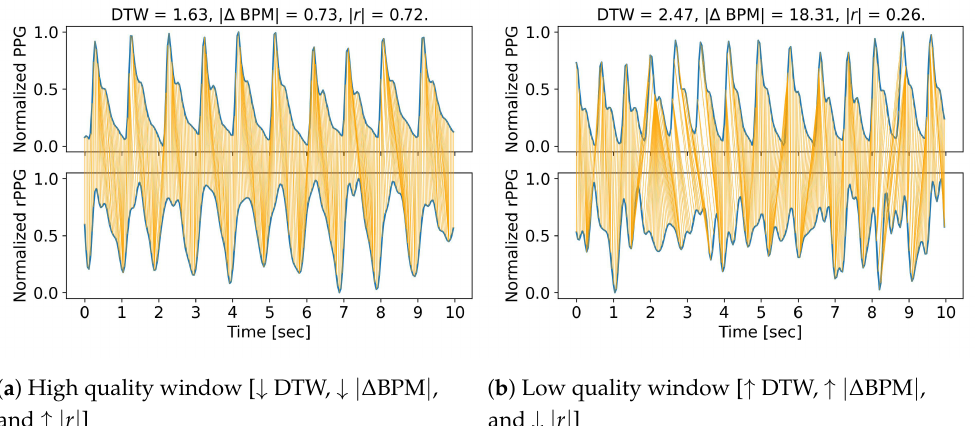
Figure 2. Comparison of a high quality window ( a ) and a low quality window ( b ). The high quality signal is from the participant named “Angelo” in the first window. It was recorded with the CHROM rPPG method at the Resting video activity with the forehead as the ROI: DTW = 1.63, | ∆ BPM | = 0.73, and | r | = 0.72. The low quality signal is from the participant named “Harun” in the first window. It was recorded with the rPPG method ICA at the Resting video activity, with the left check as the ROI: DTW = 2.47, | ∆ BPM | = 18.31, | r | = 0.26. Note that BPM = beats per minute, DTW = dynamic time warping, ICA = independent component analysis, rPPG = remote photoplethysmography, ROI = region of interest, | r | = correlation, OMIT = orthogonal matrix image transformation, PPG = photoplethysmography, ↑ = increase, and ↓ =